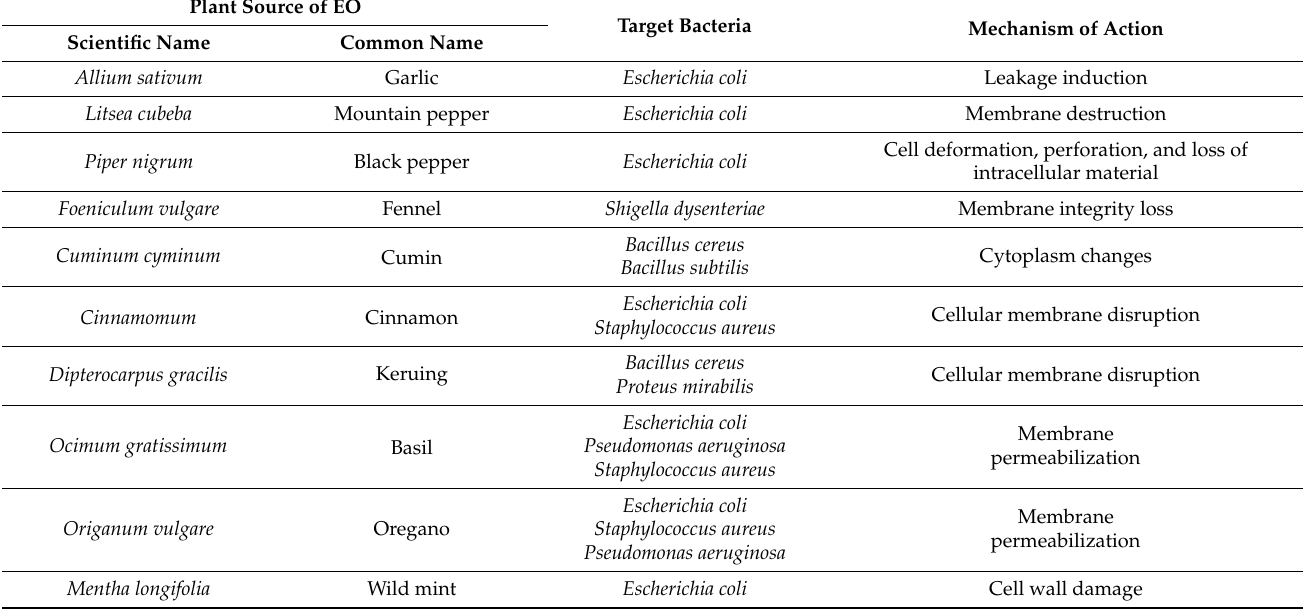
Table 2. Mechanisms of action of some EO against bacteria (adapted from